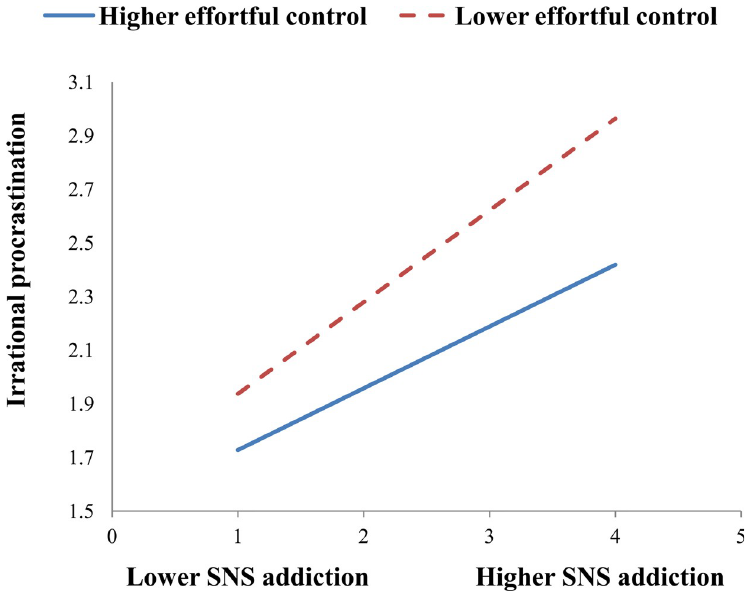
Fig 3. Effortful control moderates the relation between SNS addiction and irrational procrastination.